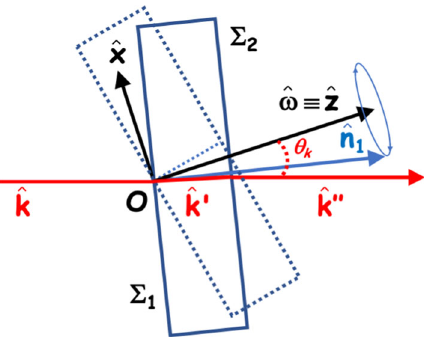
Fig. 2 Geometry of a rotating wave plate traversed by a light beam. The appropriate phase of the rotation has been chosen to have ˆ n 1 in the same plane as ˆ k and ˆ ω ; the dotted wave plate is drawn at (cid:6)φ = π with respect to the continuous line